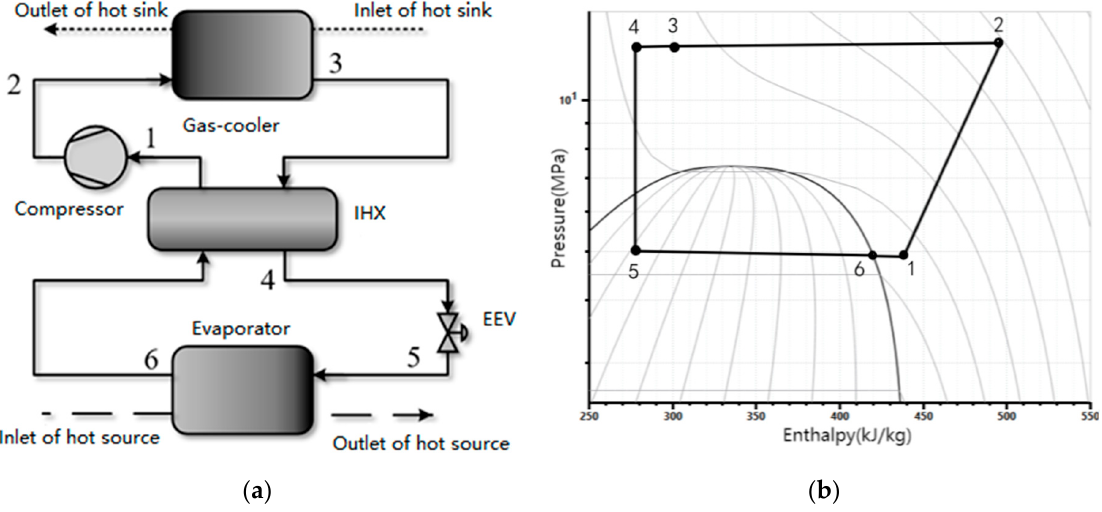
Figure 1. ( a ) The schematic of the transcritical CO 2 thermal management system. ( b ) The P-h dia- gram of the transcritical CO 2 thermal management system under common running